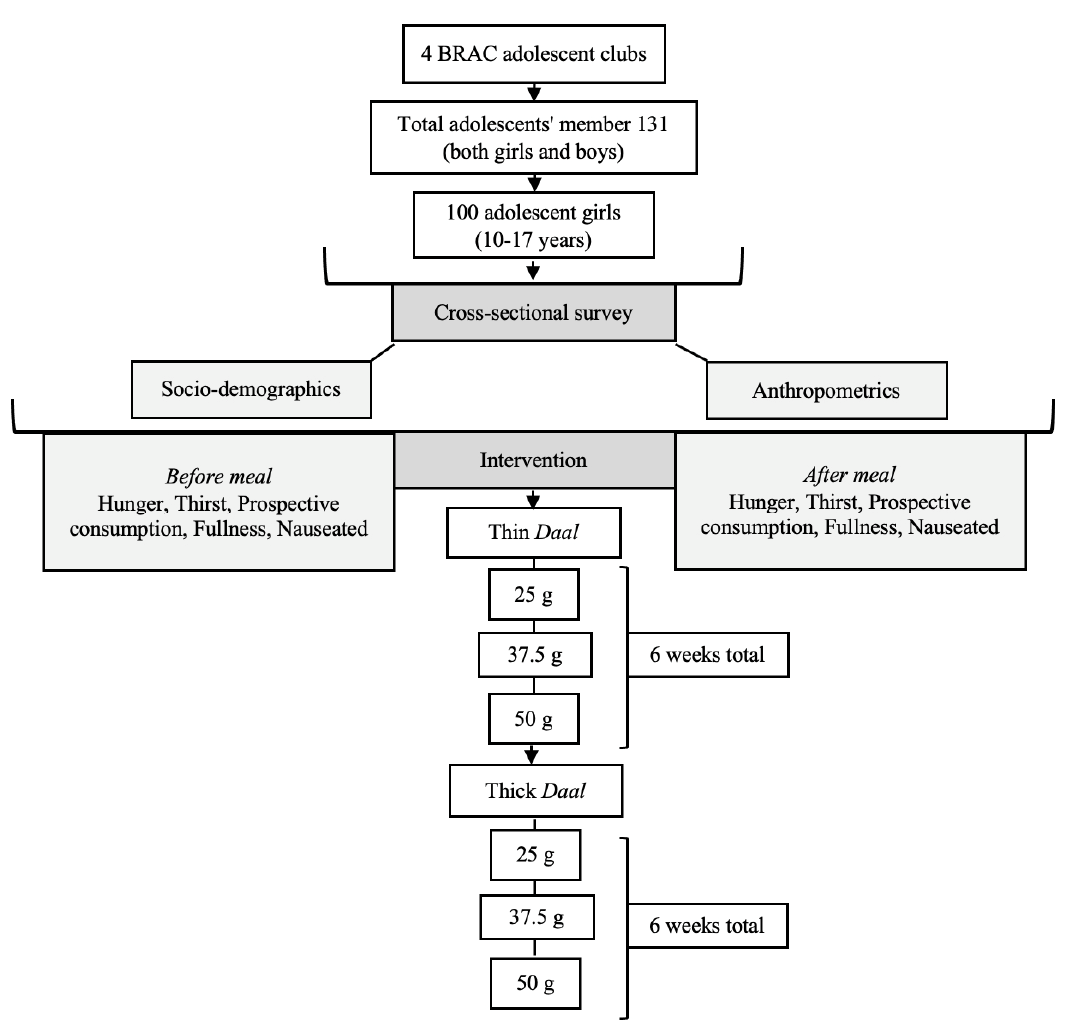
Figure 2. Study profile. BRAC, Bangladesh Rural Advancement Committee.